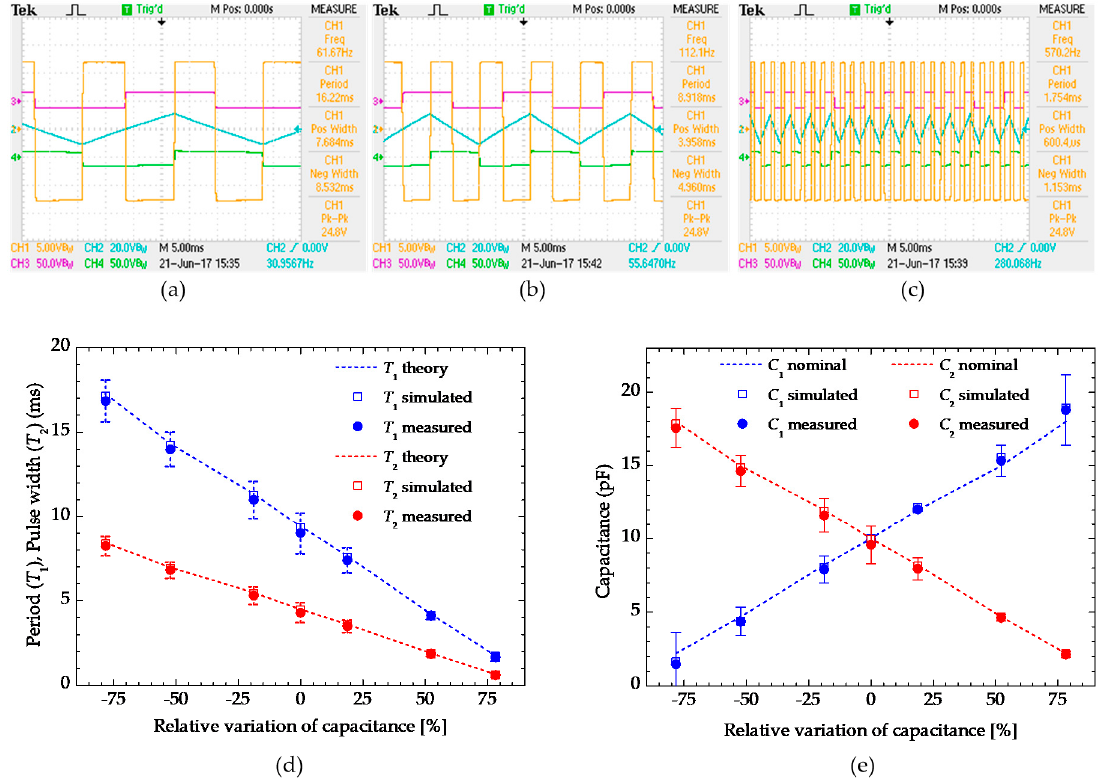
Figure 5. Measured main output signals of the circuit for ( a ) C 1 = 2.2 pF and C 2 = 18 pF, ( b ) C 1 = C 2 = 10 pF, and ( c ) C 1 = 18 pF and C 2 = 2.2 pF; ( d ) measured, simulated and theoretical oscillation periods T 1 and pulse widths T 2 as a function of the relative differential capacitance variation; ( e ) calculated/estimated capacitance values.